Question: State the chart type depicted above.
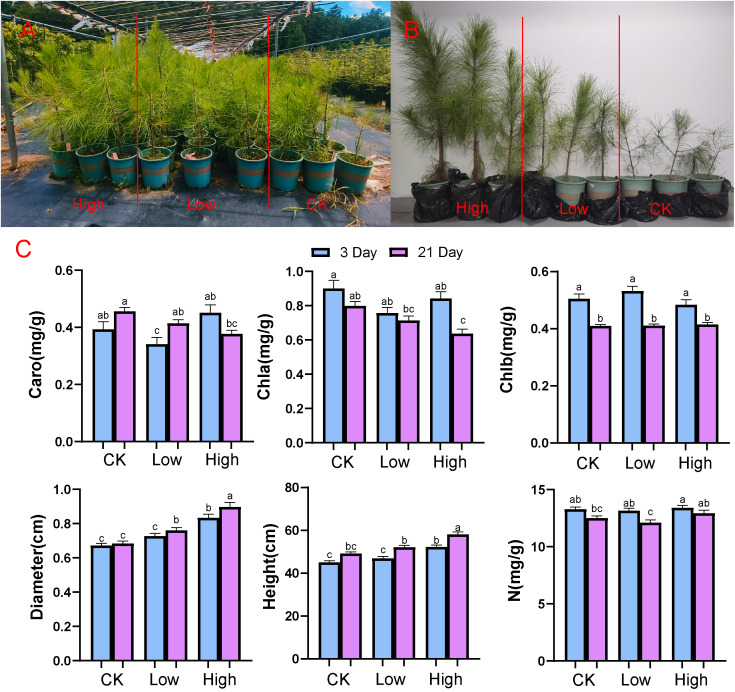
Answer: bar